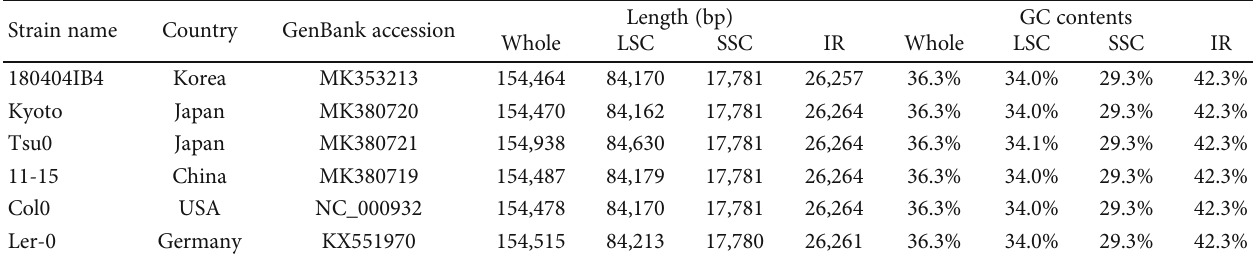
Table 1: List of chloroplast genomes of East Asian Arabidopsis